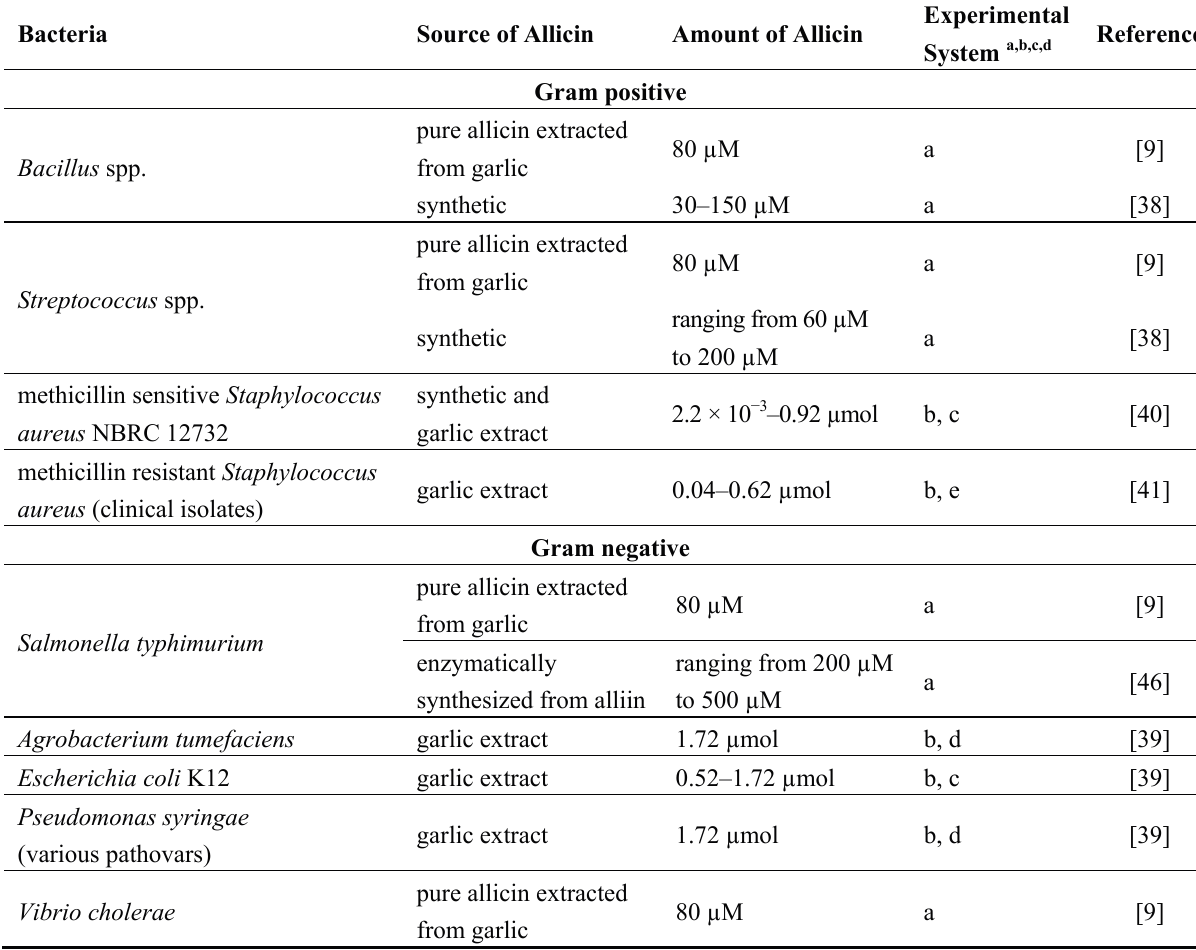
Table 1. Examples of allicin’s antibacterial